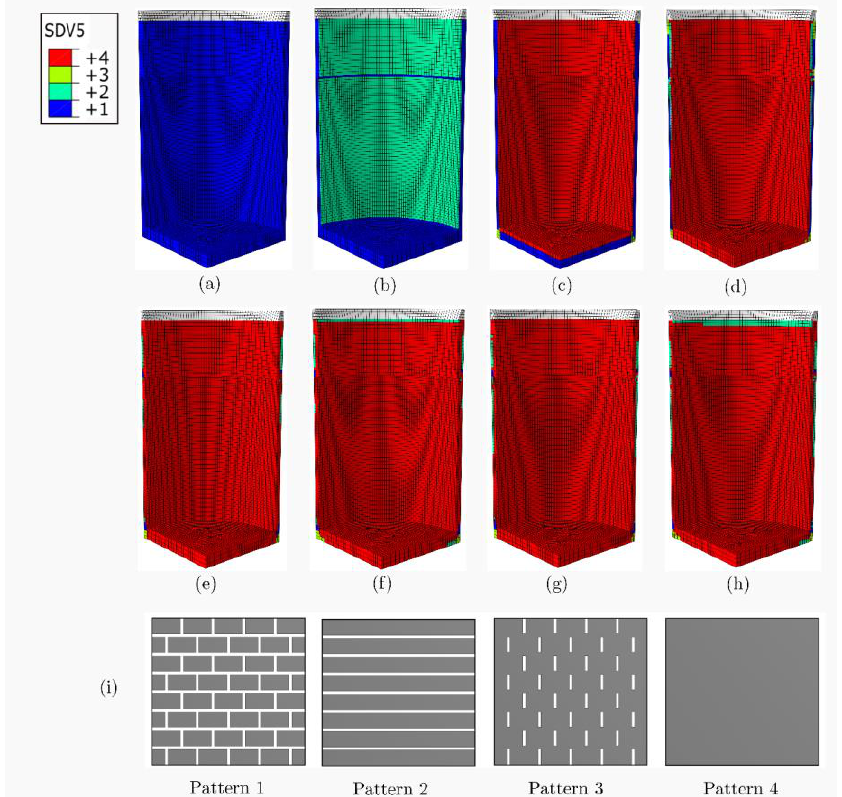
Figure 10. Gradual closure and reopening of joints due to temperature fluctuations during the first heating cycle for joint thickness of 0.1 mm. ( a ) Time = 0 s (point a in Figure 7), ( b ) time = 460 s, ( c ) time = 675 s, ( d ) time = 1825 s ((b) to (d) correspond to points after point a and before point b in Figure 7), ( e ) time = 7500 s (point b in Figure 7), ( f ) time = 24,300 s (point c in Figure 7), ( g ) time = 24,500 s (point d in Figure 7), ( h ) time = 33,300 s (point e in Figure 7), and ( i ) schematic of the four joint patterns.